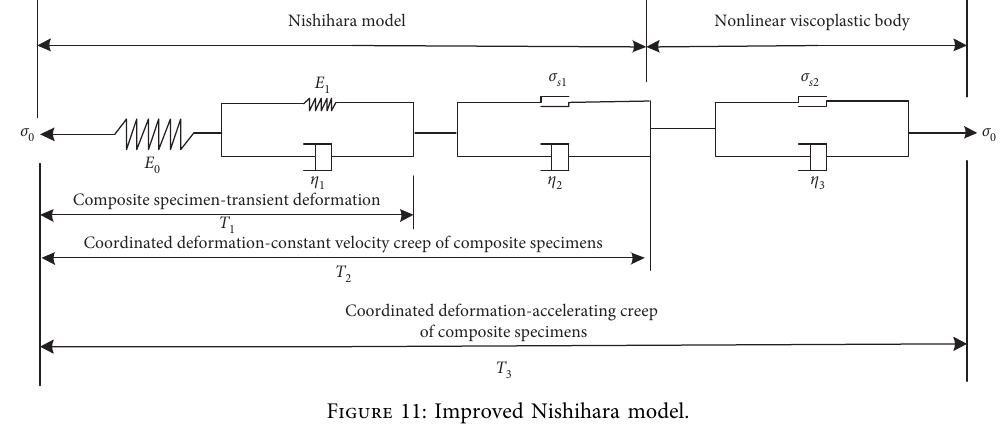
Figure 11: Improved Nishihara